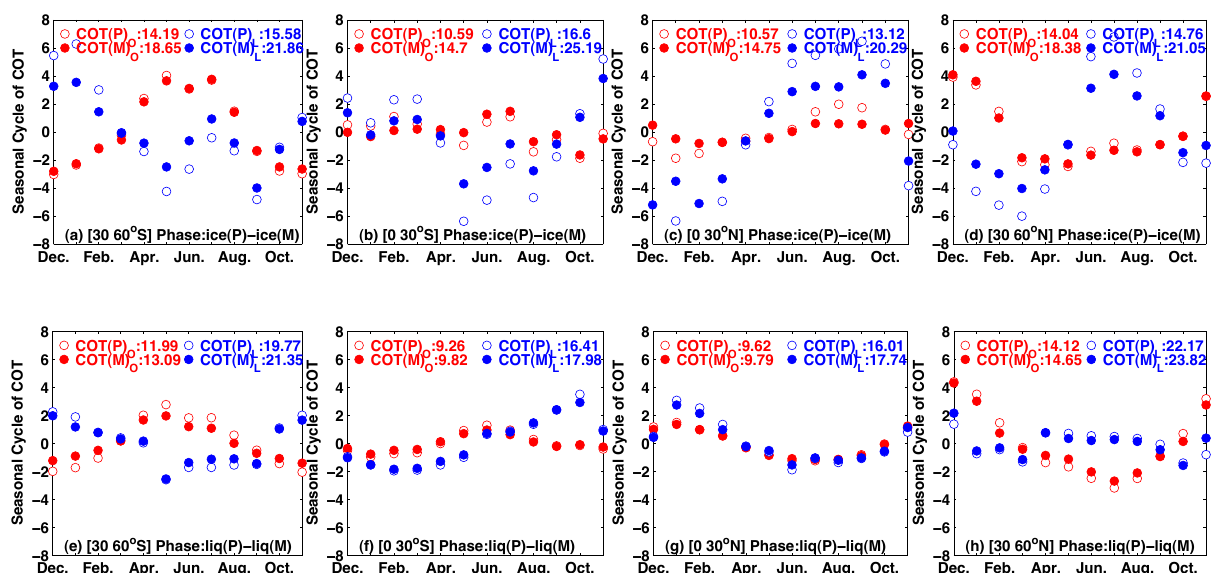
Fig. 3. Seasonal cycles of COT for overcast clouds over South Hemisphere mid-latitude regions (30–60 ◦ S) (first column) and tropical regions (0–30 ◦ S) (second column), over North Hemisphere tropical regions (0–30 ◦ N) (third column) and mid-latitudinal regions (30–60 ◦ N) (fourth line) with different combined cloud phases: POLDER-ice and MODIS-ice (first line), and POLDER-liquid and MODIS-liquid (second line). Ocean data are in red and land data in blue. The solid circles present data from MODIS and the hollow circles from POLDER. The values in the figures correspond to annual mean COT in the